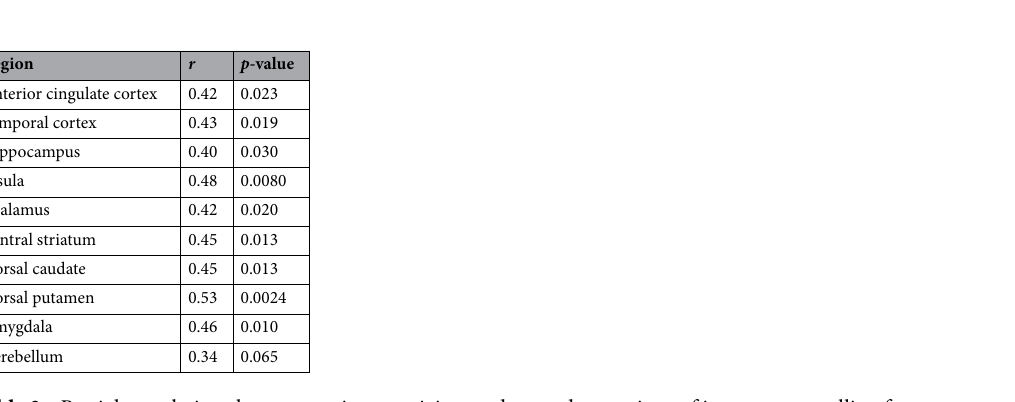
Table 3. Partial correlations between trait neuroticism and secondary regions of interest, controlling for